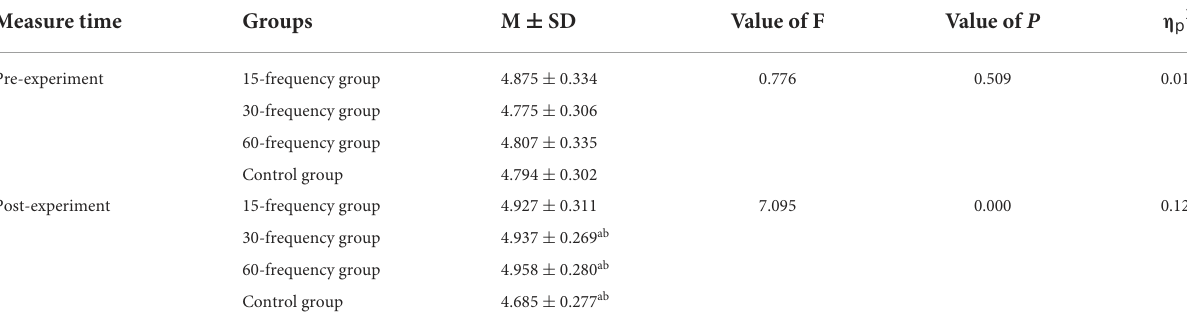
TABLE 6 Simple effect analysis and paired-sample t -test on subjects’ uncorrected distance visual acuity.